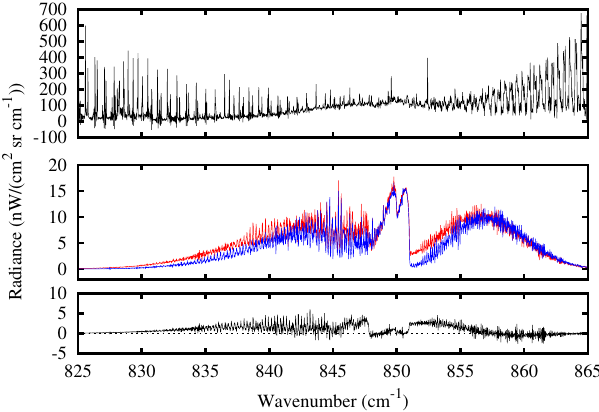
Figure 1. Top panel: simulated spectra at 21.2km tangent altitudes for midlatitude atmospheric conditions in the 825–865cm − 1 spec- tral region using the mipas_pf4.45 database containing the new phosgene lines. Middle panel: contribution of the new phosgene linelist (red line) and of the ATMOS 1995 phosgene lines (blue line). Bottom panel: difference between the new phosgene linelist and the ATMOS 1995